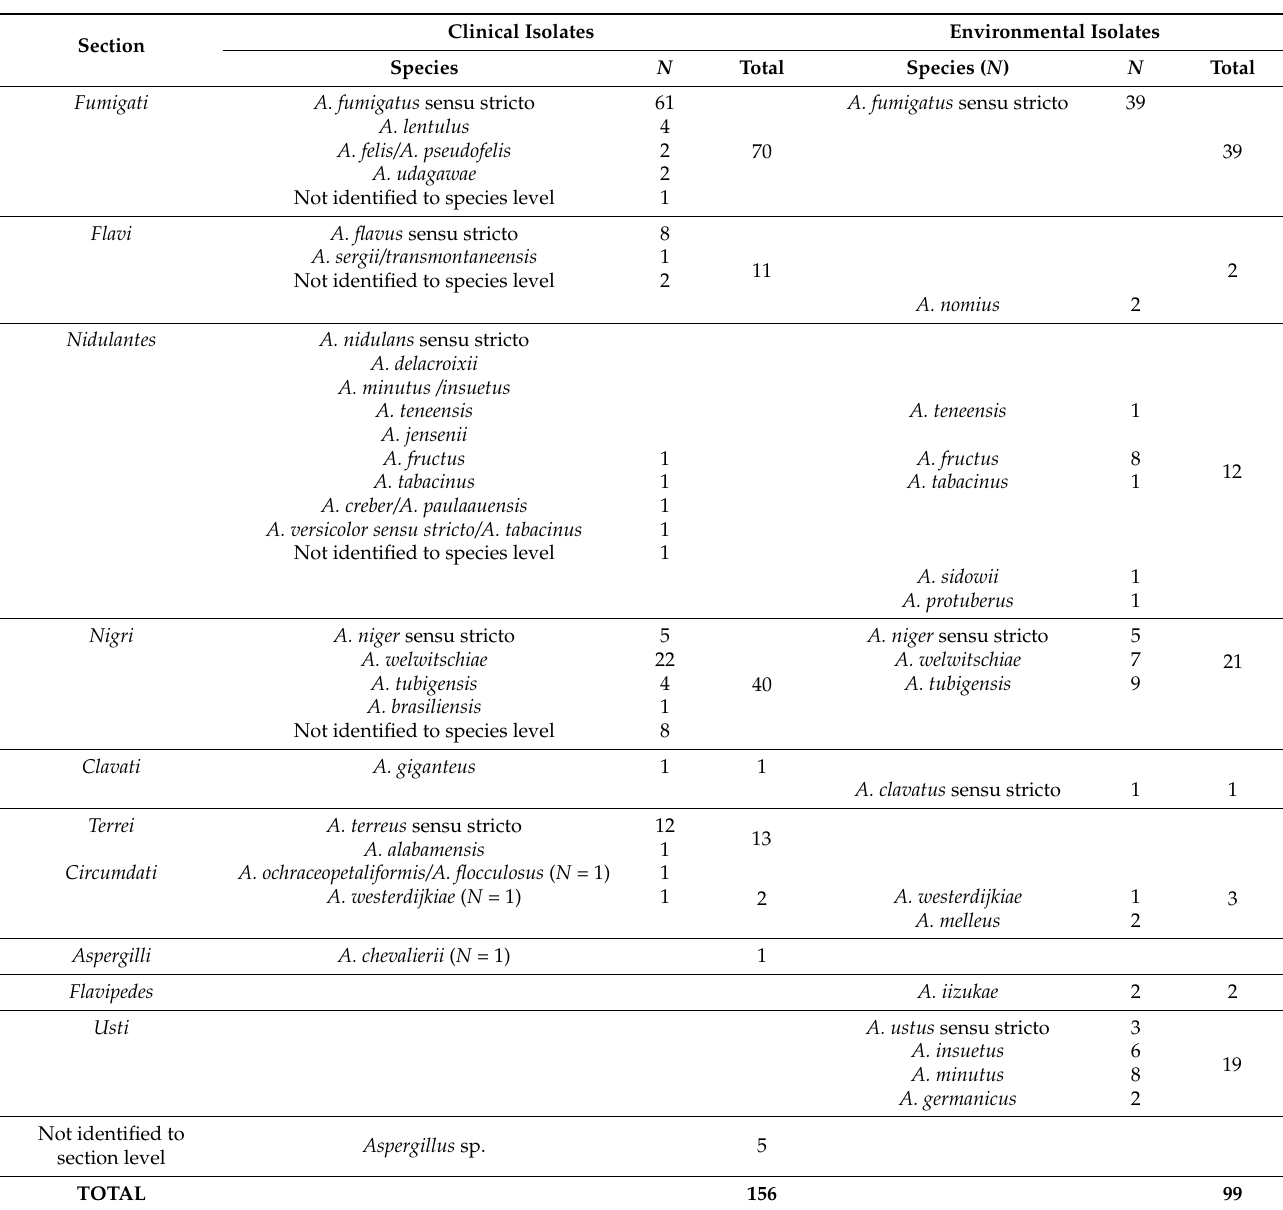
Table 1. Clinical and environmental Aspergillus species collected at the National Reference Laboratory in the scope of the Aspergillus surveillance program